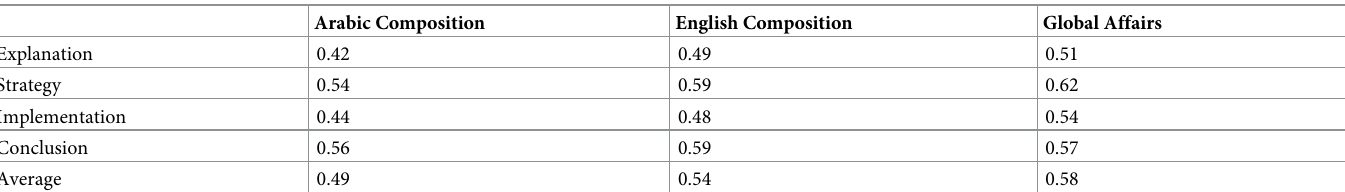
Table 4. Criterion validity.